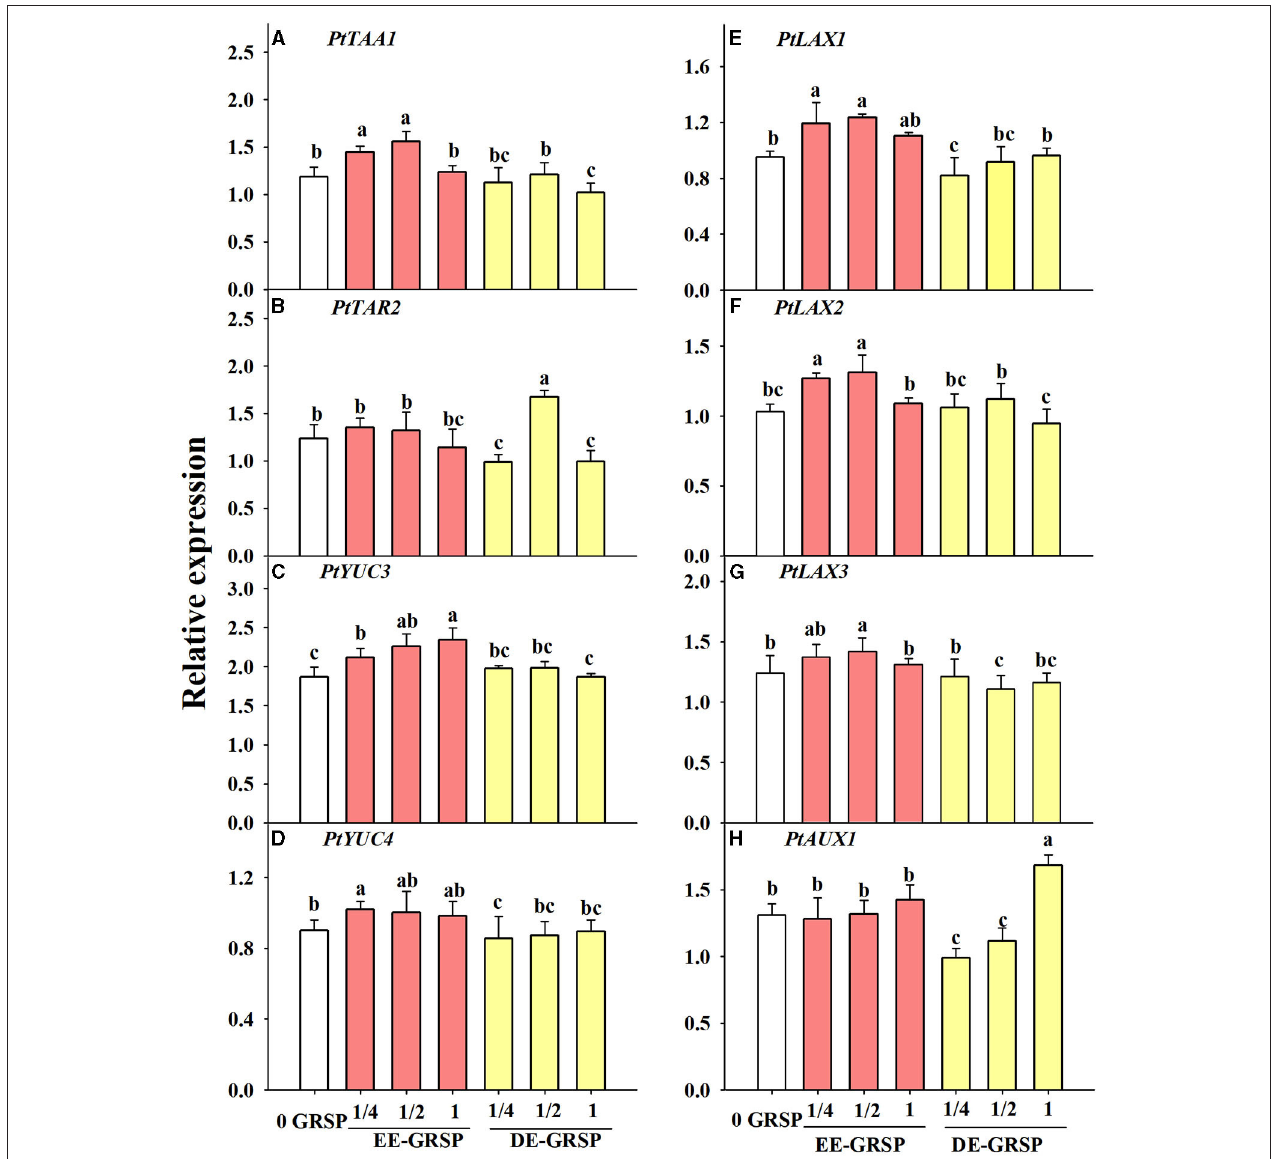
FIGURE 7 | Effects of exogenous EE-GRSP and DE-GRSP on relative expression levels of auxin synthetase genes (A–D) and transporter protein genes (E–H) in roots of trifoliate orange seedlings. Data (mean ± SD, n = 4) followed by different letters above the bars indicate significant differences ( p < 0.05). DE-GRSP, difficultly extractable glomalin-related soil protein; EE-GRSP, easily extractable glomalin-related soil